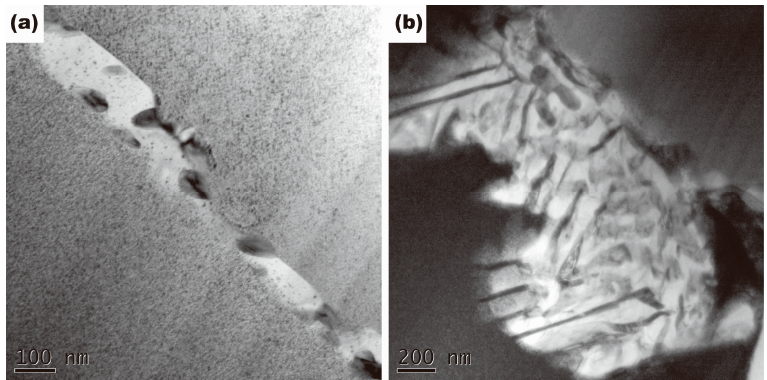
Figure 5. TEM images of the morphology of discontinuous precipitation in 0.02% Ti alloy aged at 400 °C for 4 h: ( a ) Initiation of discontinuous precipitation in grain boundaries; ( b ) Typical colony of discontinuous precipitation.